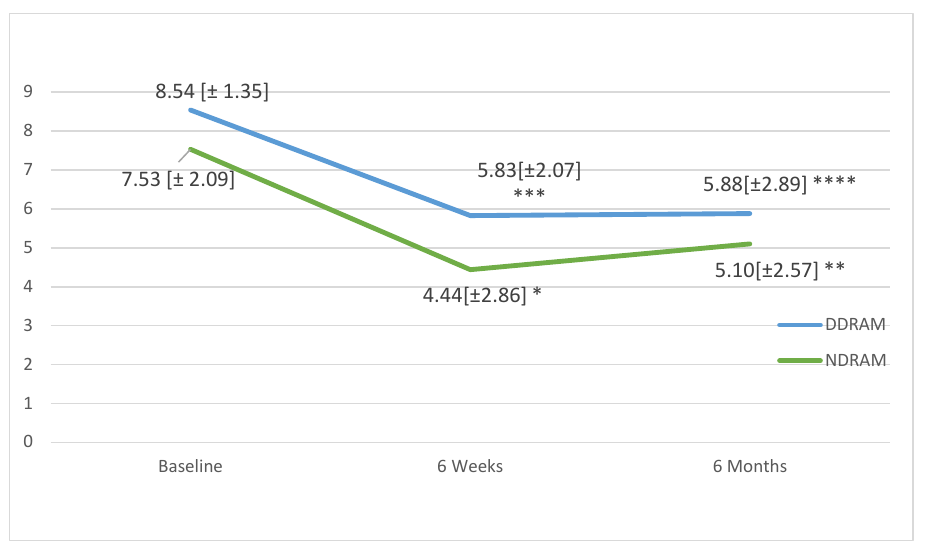
Figure 2. Change in low back pain as measured on a visual analogue scale in each study group throughout the follow-up . Values expressed in means and standard deviations. p -values calculated with paired Student’s t -test. * p <0.001, ** p = 0.017, *** p < 0.001, **** p = 0.002.